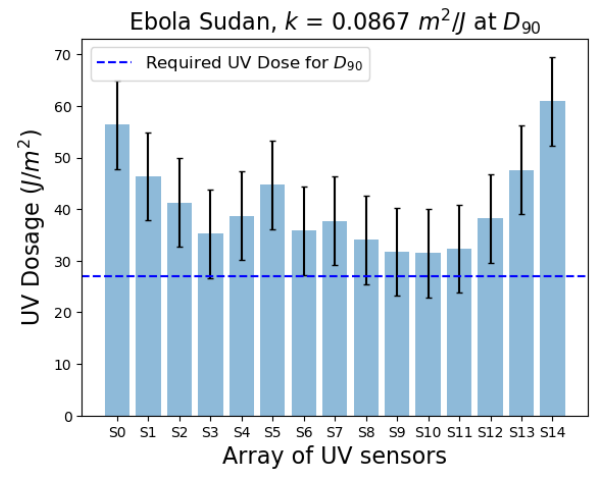
Figure 13. UV Dose measurements for Ebola Sudan at D 90